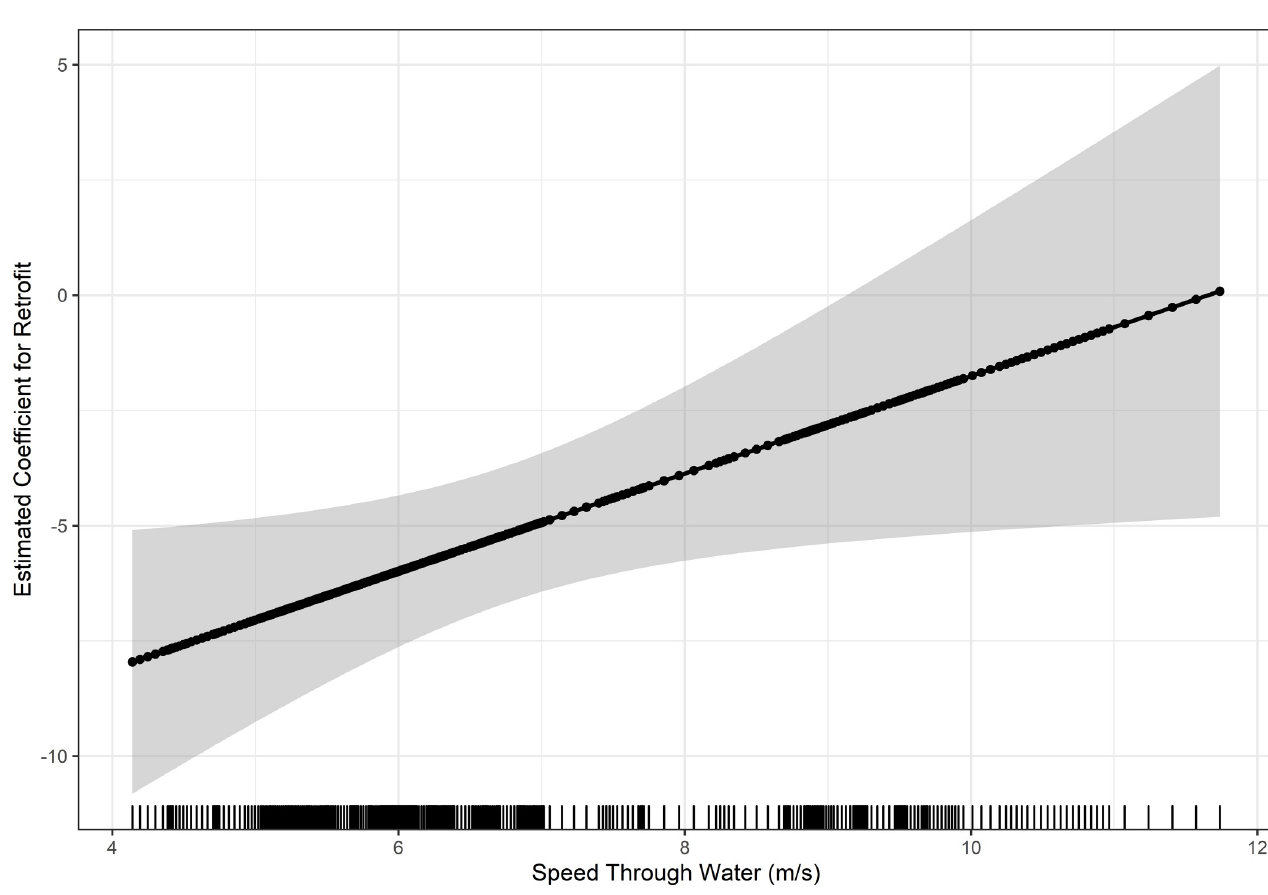
Fig 9. Investigation into monopole source level interaction with speed through water. Noise reduction of retrofit (dB) with Speed Through Water for low- frequency (8–40 Hz) monopole source level. Estimated coefficients and 95% confidence intervals are